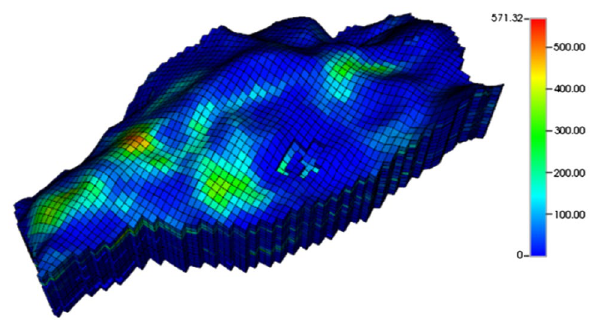
Fig. 1 PP i map for the active blocks of the reservoir